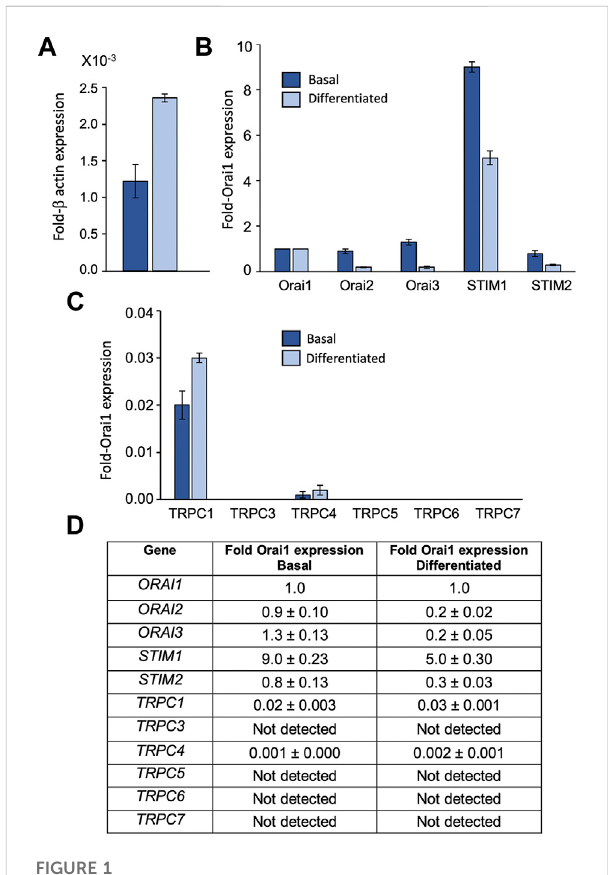
FIGURE 1 HaCaT keratinocytes express transcripts for Orai1, 2, 3, STIM1, 2 and TRPC 1, 4 HaCaT mRNA expression from basal (dark blue) and differentiated HaCaT cells (light blue) as determined by qRT-PCR. Results are presented relative to β -actin (A) or Orai1 expression (B,C) .AllSTIM,OraiandTRPCresultsareshownasmean±SEMfor N = 3 experimental replicates (D)